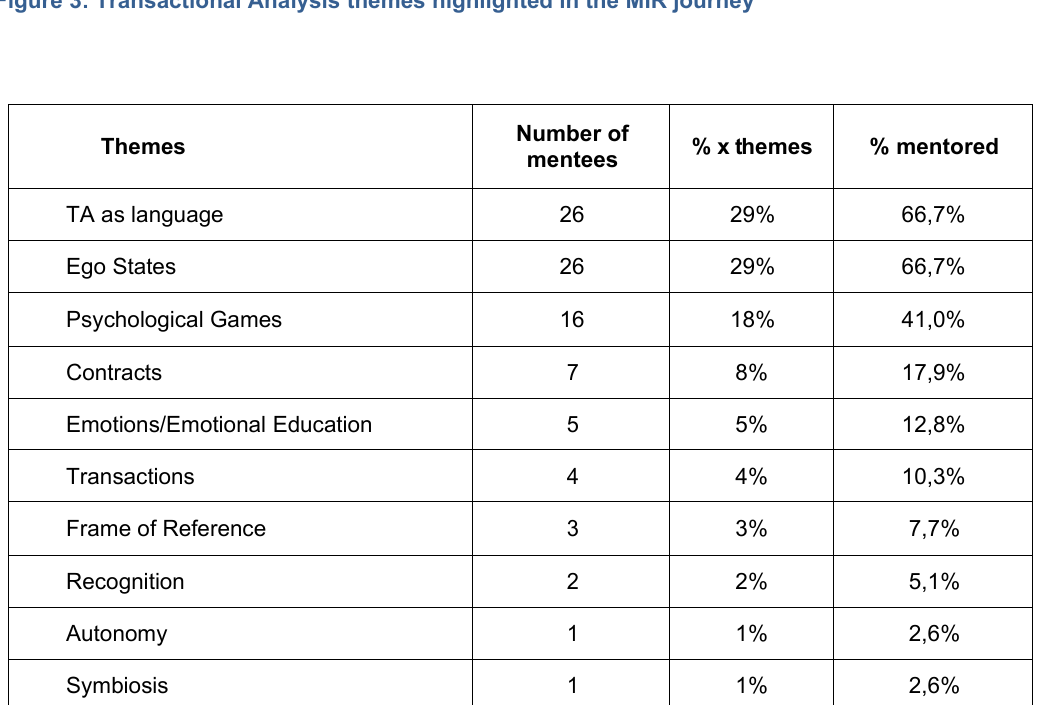
Figure 3: Transactional Analysis themes highlighted in the MIR journey